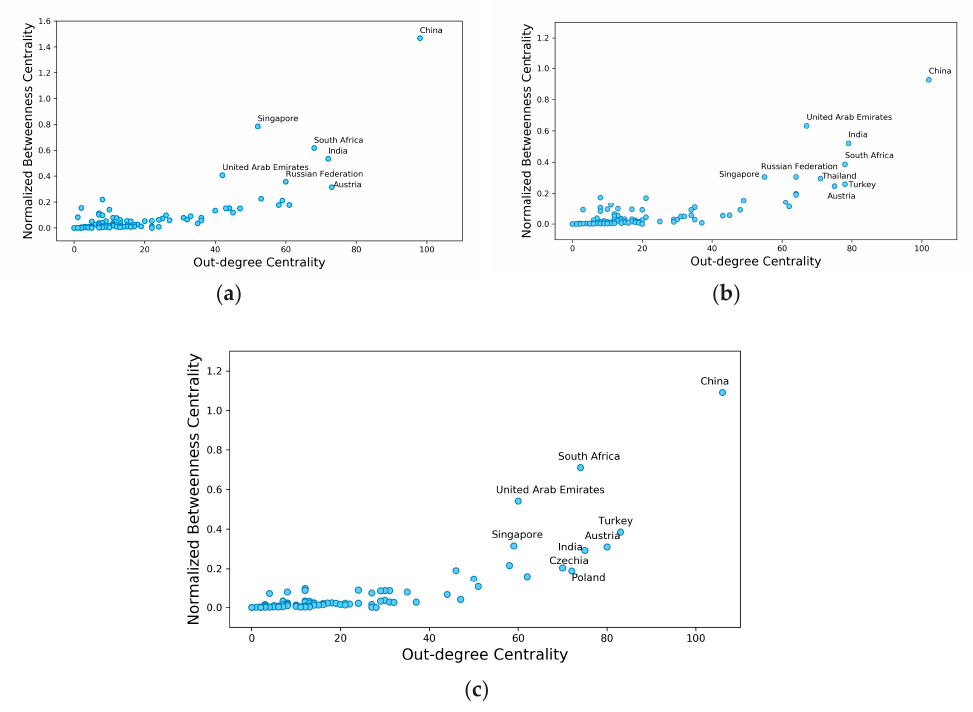
Figure 9. Out-degree centrality versus normalized betweenness centrality. ( a ) phase 1 (2003–2008), ( b ) phase 2 (2009–2013), ( c ) phase 3 (2014–2017). Only several countries high in normalized betweenness centrality and out-degree centrality are